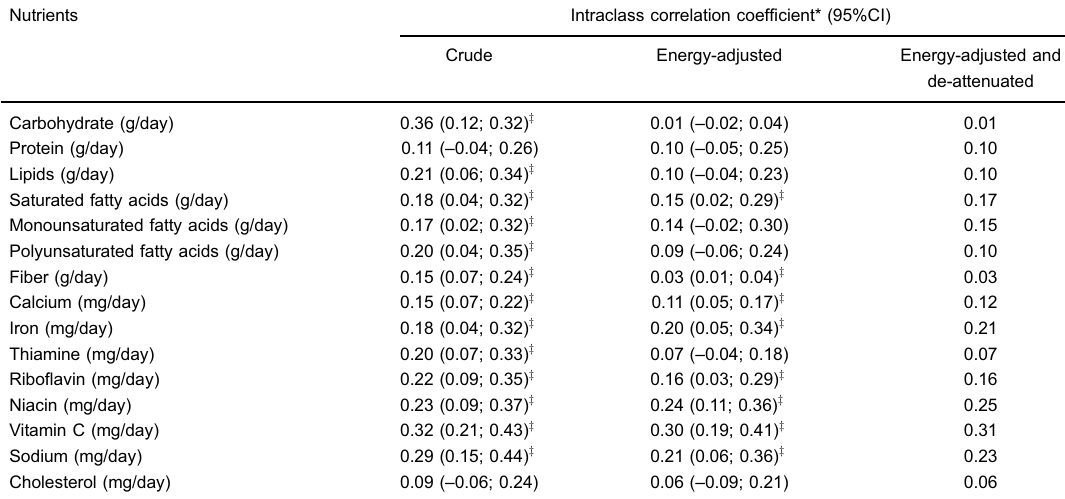
Table 3. Interclass correlation coef fi cient of nutrient intake measured with the 24-hour recalls and the food frequency questionnaire. Nutrients